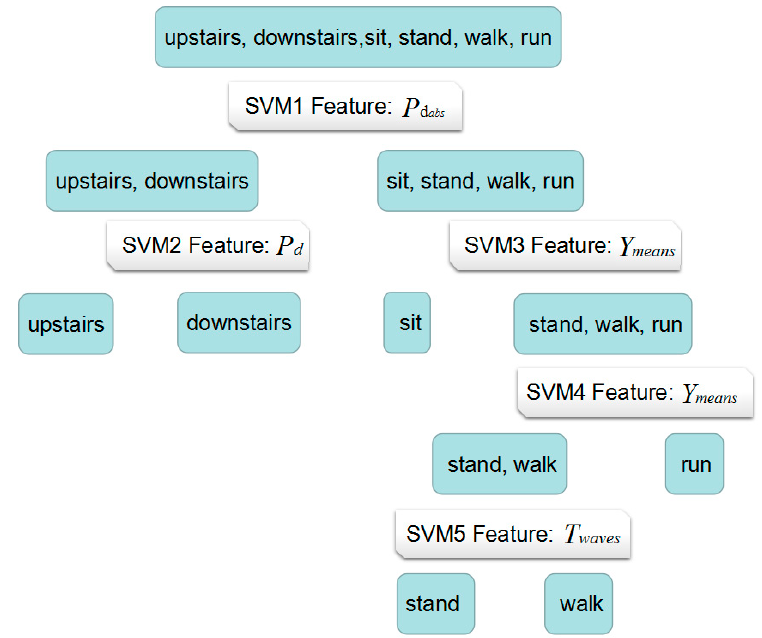
Figure 5. The whole H-SVM classification model.